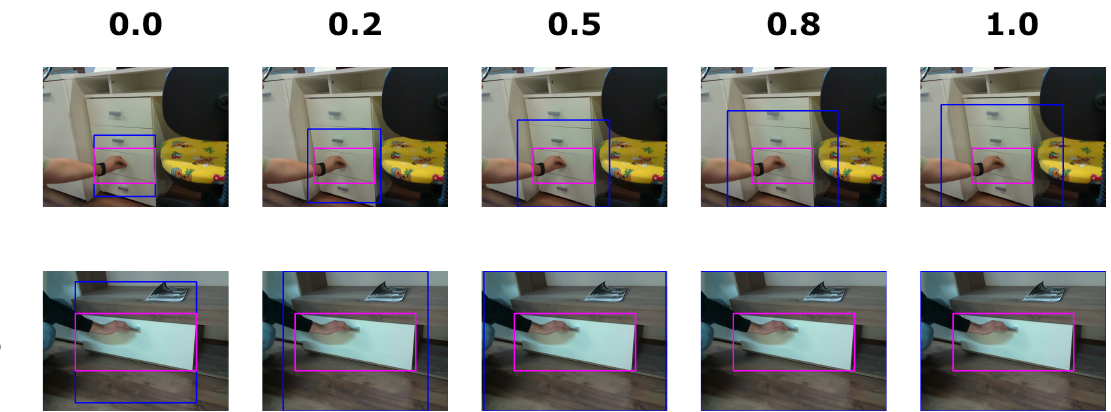
Figure 8. Examples of squarification with different values of dim increase . The ground truth bounding boxes are shown in magenta, while the squarified bounding boxes are shown in